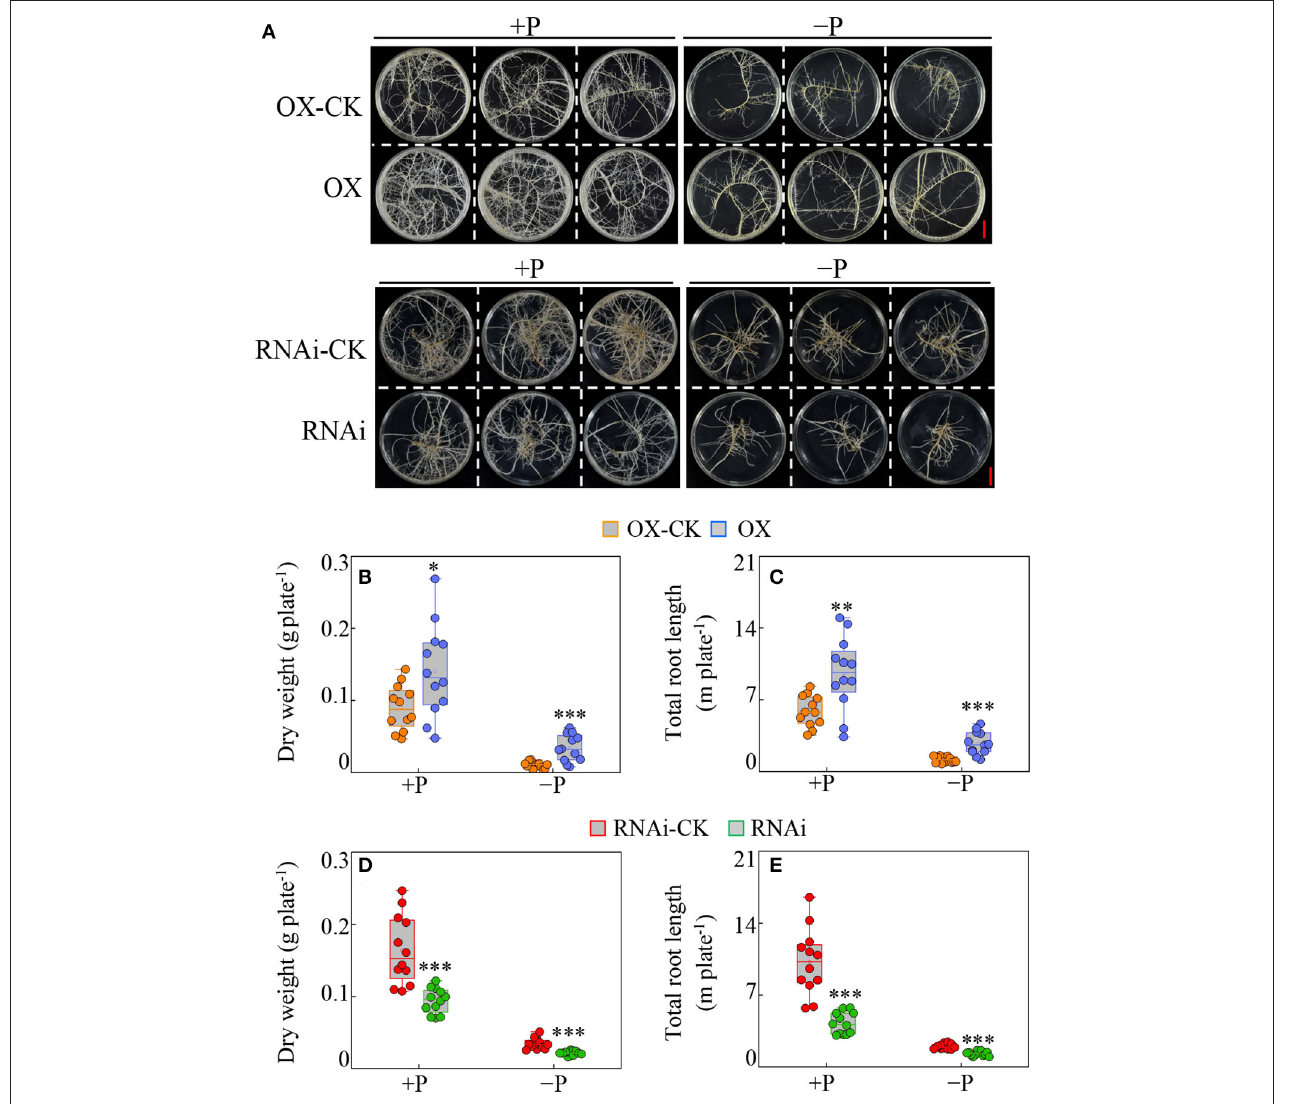
FIGURE 4 | Effects of GmBBE-like43 overexpression (OX) and RNA-interference (RNAi) on transgenic soybean hairy roots in response to low P treatment. (A) Phenotypes of transgenic soybean hairy roots in response to P availability. (B–E) Dry weight (B,D) and total root length (C,E) of soybean hairy roots with either GmBBE-like43 overexpressing (B,C) or GmBBE-like43 RNA-interference (D,E). For P treatments, uniform soybean hairy roots were selected and transferred to MS medium with either 10 µ M (–P) or 1250 µ M ( + P) KH 2 PO 4 . The hairy roots expressing 35S:: GmBBE-like43 (OX) and pTF101s empty vector control (OX-CK) were harvested 14 days after P treatment, while the GmBBE-like43 RNA-interference (RNAi) and its pFGC5941 empty vector control (RNAi-CK) were sampled after 21 days of P treatment. Asterisks indicate significant difference between transgenic hairy roots with either GmBBE-like43 overexpressing or RNA-interference and their corresponding empty vector controls according to Student’s t -test: * : P < 0.05; ** : 0.001 < P < 0.01; *** : P <